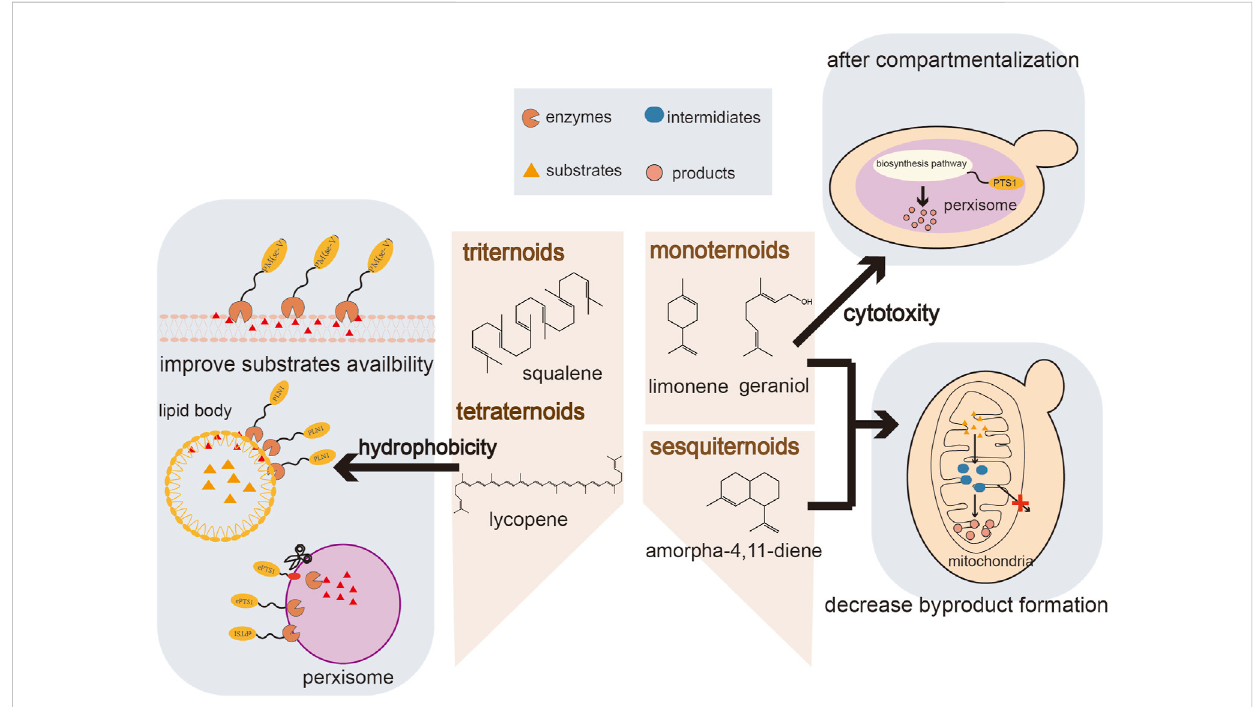
FIGURE 1 An overview of compartmentalization strategies for terpenoid